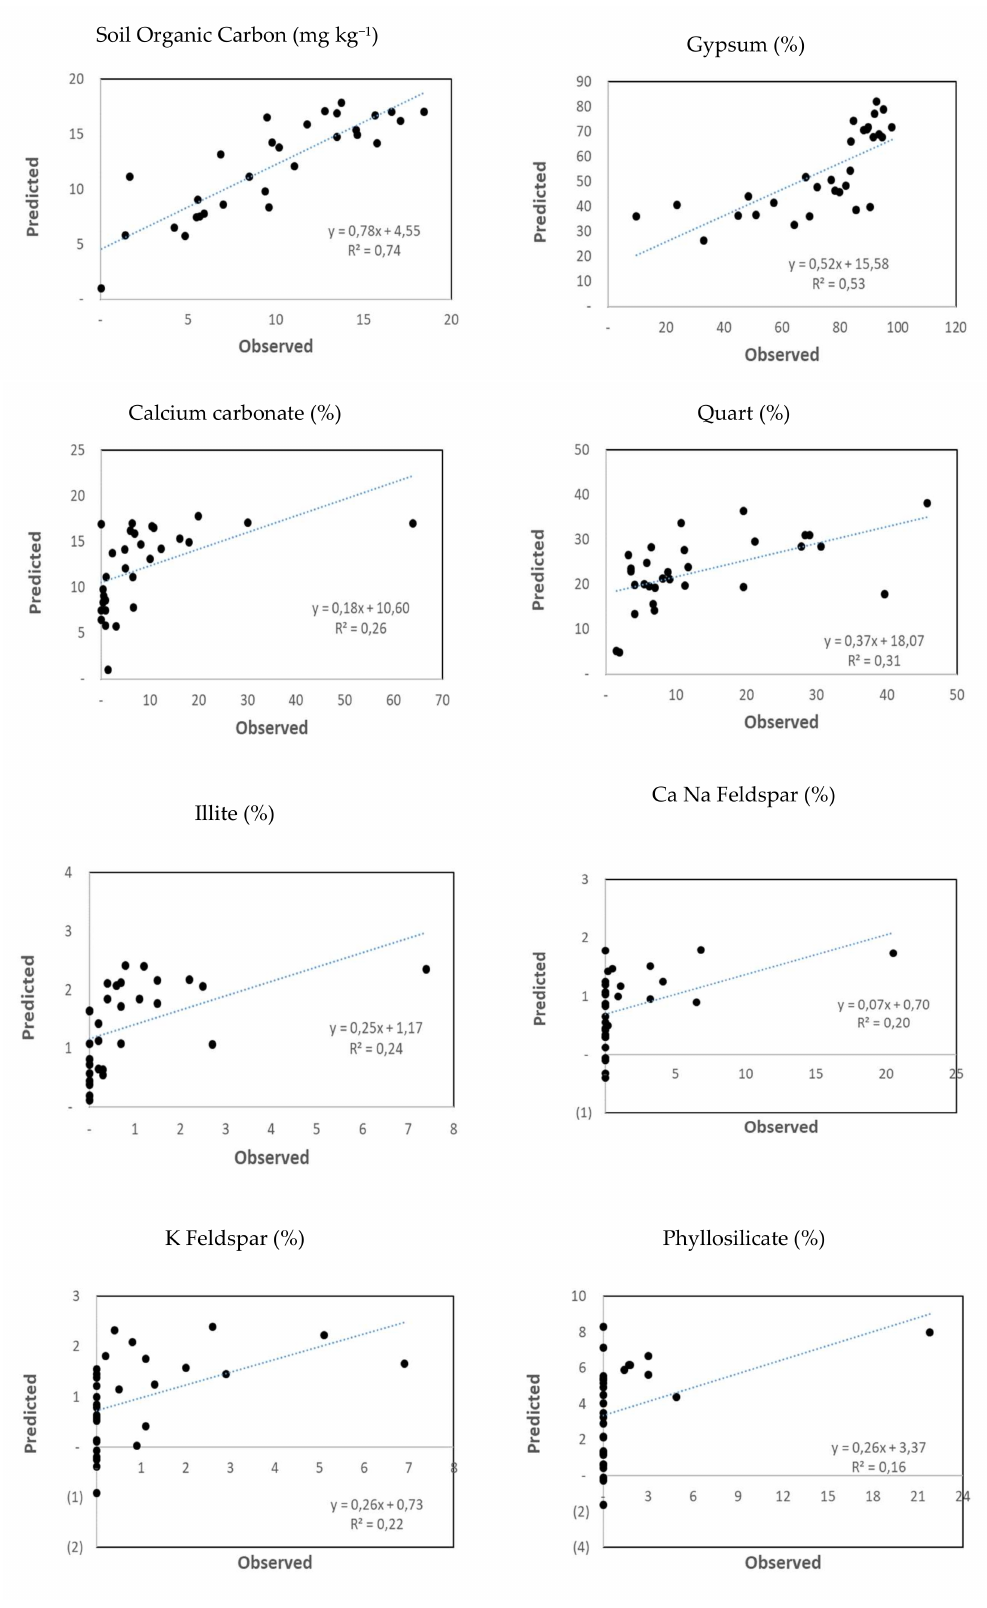
Figure 3. Cross-validation results of ParLeS software for soil physical–chemical variables. Observed versus predicted